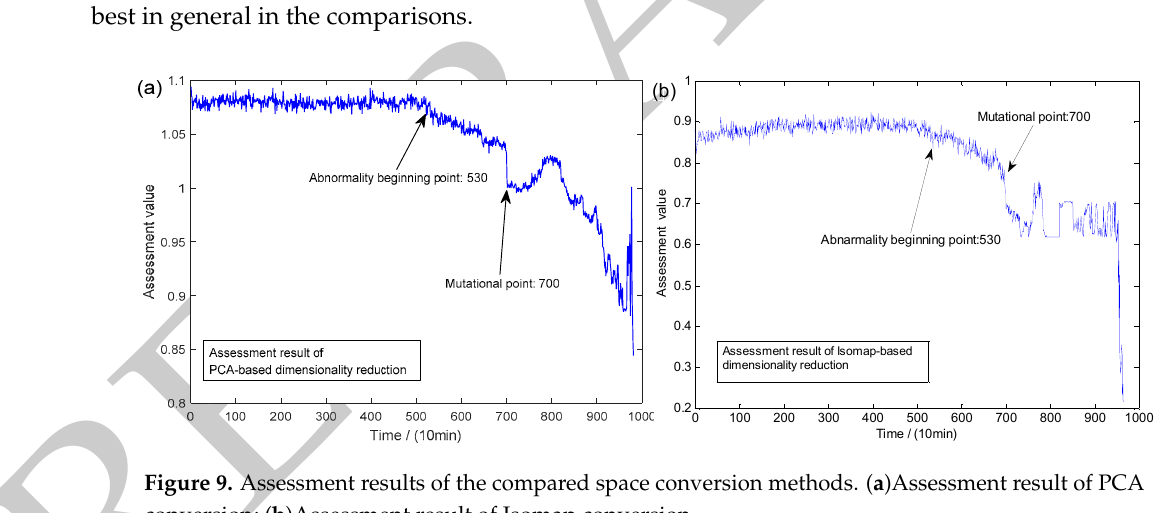
Figure 9. Assessment results of the compared space conversion methods. ( a )Assessment result of PCA conversion; ( b )Assessment result of Isomap conversion